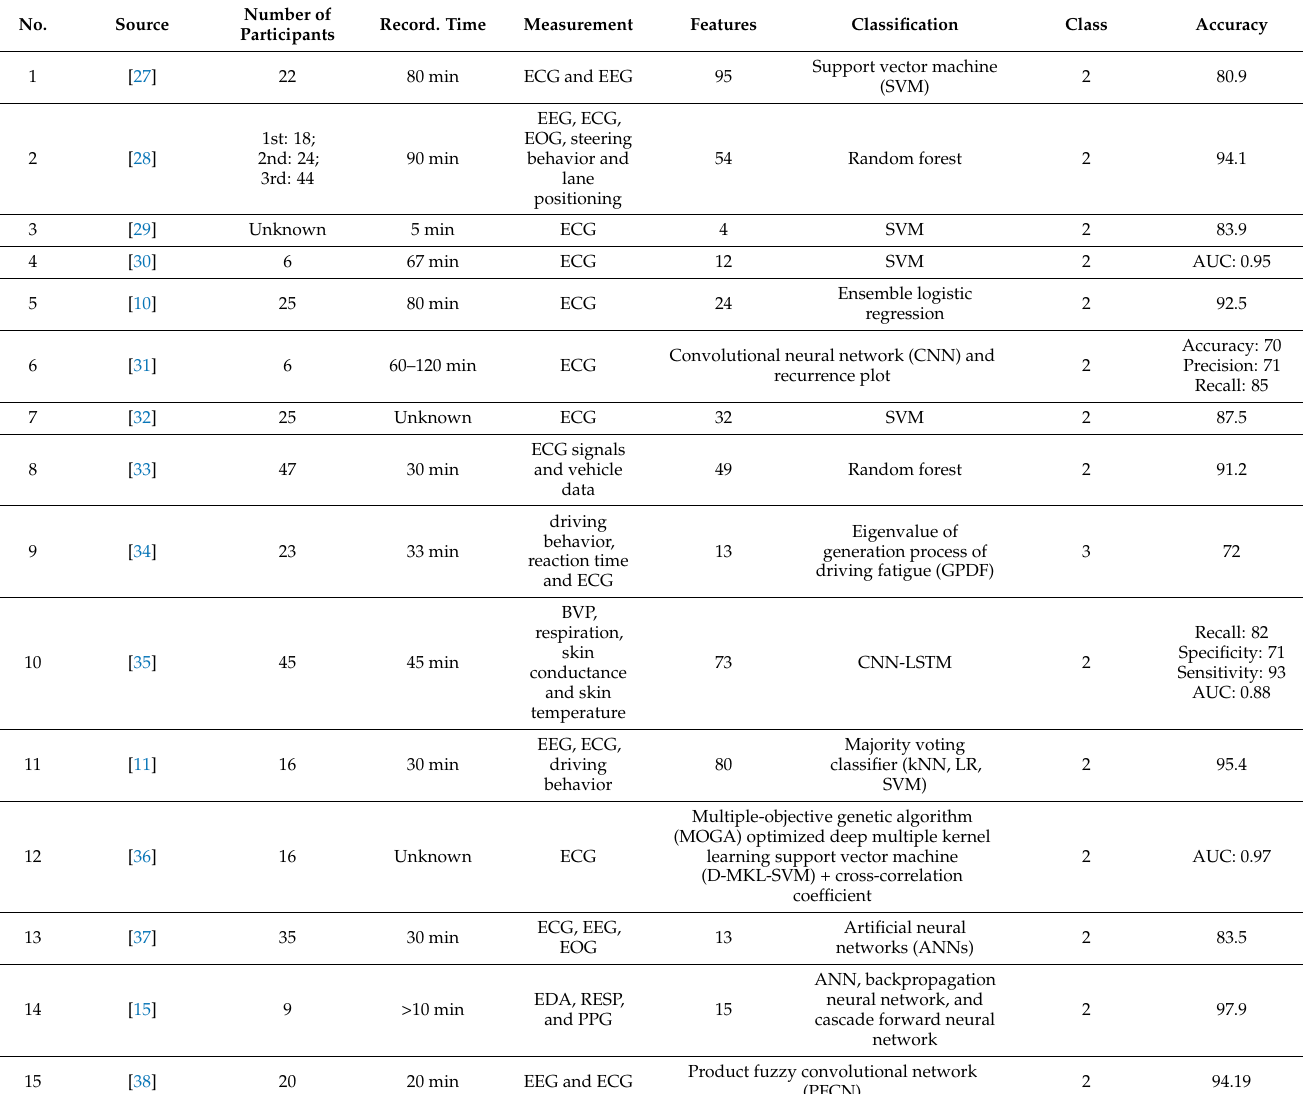
Table 1. The literature on fatigue or drowsiness driving detection using ECG and other heart rate- related sensor